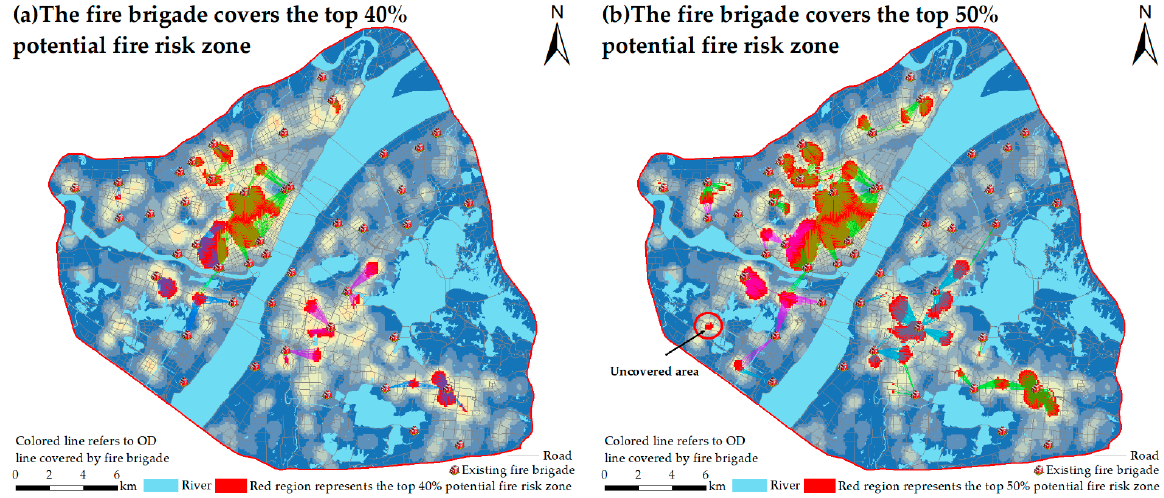
Figure 13. Spatial distribution of proximity of existing fire brigades to fire-risk areas. ( a ) Fire brigade covers the top 40% potential fire-risk zones. ( b ) Fire brigade covers the top 50% potential fire-risk zones.